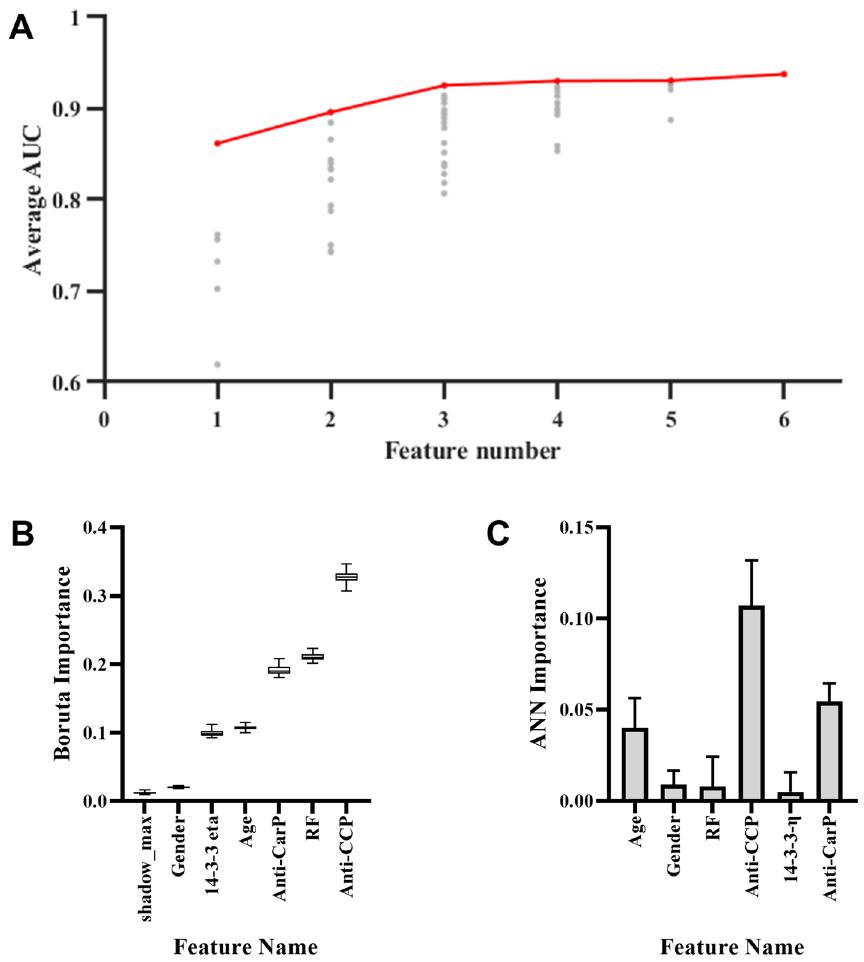
Figure 1. Feature selection and importance evaluation. ( A ) The model AUC increases when the number of used features increases, each grey dots indicate a combination, and the best subset of each feature number is colored red. ( B ) All features outperformed the max shadow feature in Boruta test, indicating that all features are important. The horizontal line indicates that the median and the whiskers are min to max; ( C ) In ANN